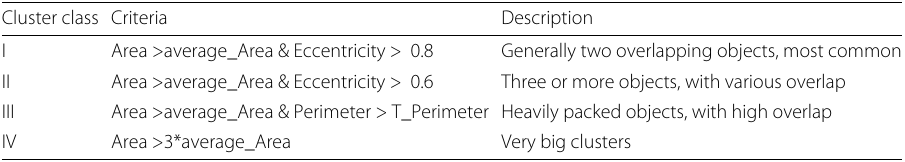
Table 1 The classification of clusters Cluster class Criteria